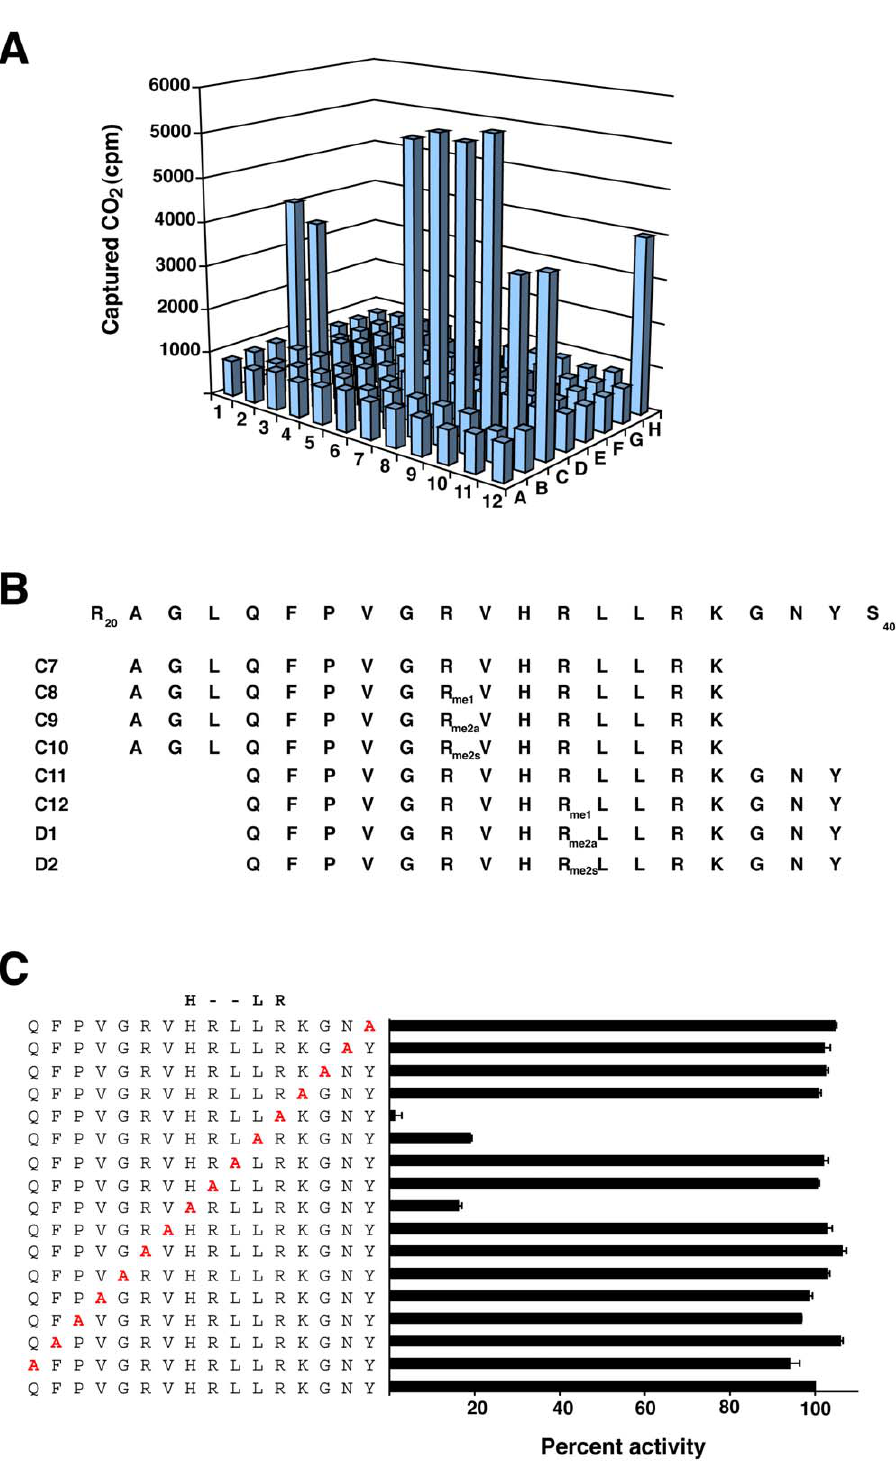
PLoS ONE | www.plosone.org